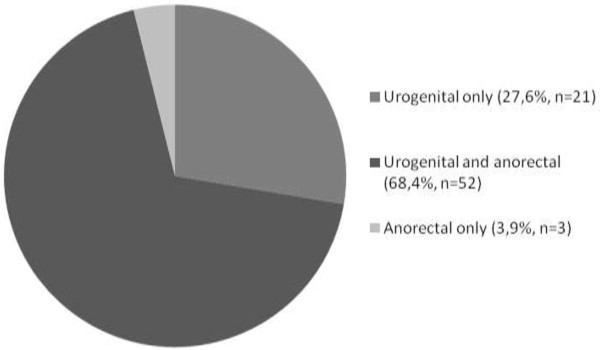
Anatomic site distribution of chlamydia in women attending the STI clinic routinely screened for urogenital and anorectal chlamydia.